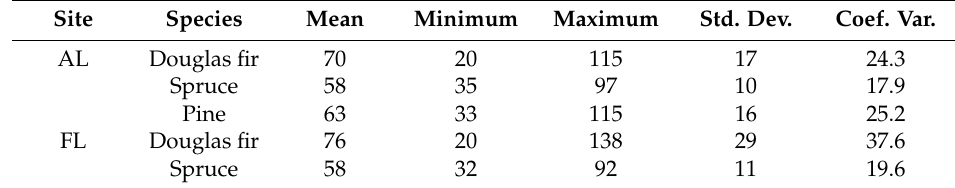
Table 4. Bending strength (in MPa) of individual tree species according to the evaluated site.